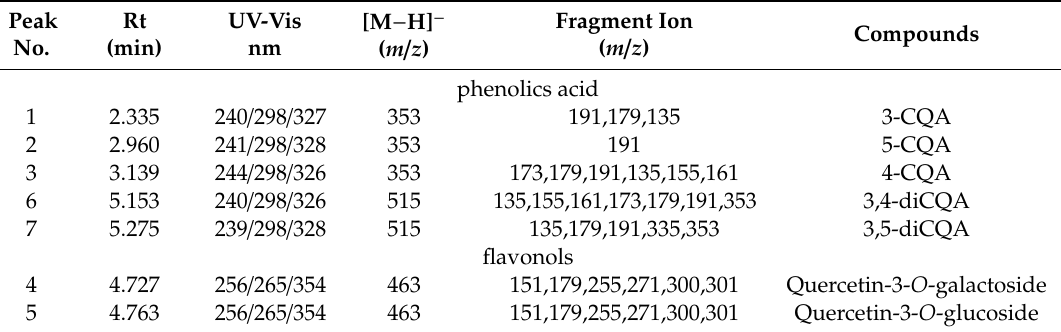
Table 1. Characterisation of phenolics compounds from sweet potato extracts collected from the HPLC column and analysed by UV-VIS, HPLC, and LC / MS. 3-CQA: chlorogenic acid, 5-CQA: neochlorogenic acid, 4-CQA: 4-cryptochlorogenic acid, 3,4-diCQA: 3,4-di- O -caffeoylqunic acid, 3,5-diCQA: 3,5-di- O -caffeoylqunic acid.